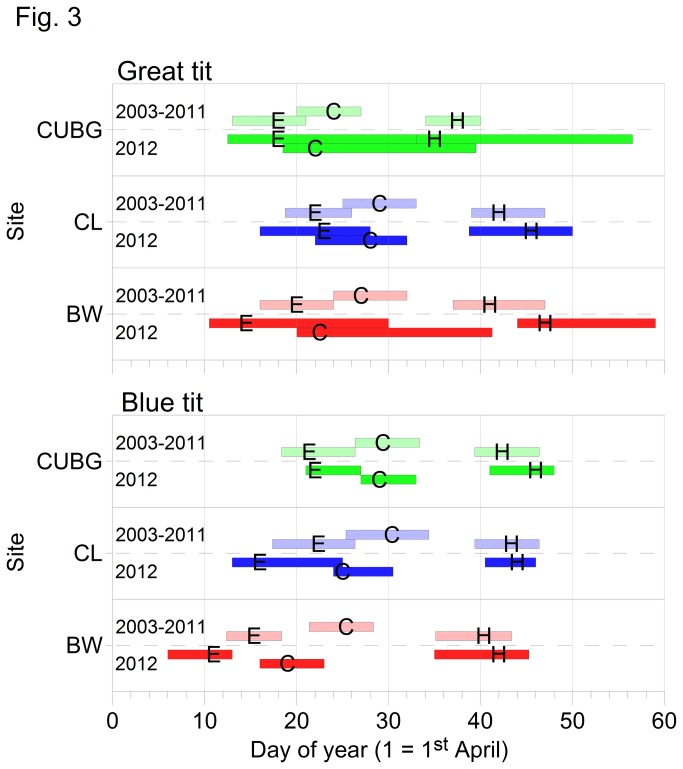
Average timing of nesting events for great tits (GT) and blue tits (BT) at Cambridge University Botanical Gardens (CUBG; green), Cow Lane Nature Reserve (CL; blue) and Brampton Wood Nature Reserve (BW; red).Symbols denote median dates for first egg (E), clutch completion (C; and earliest potential start of incubation) and hatching (H) and the bars show the interquartile range for the 9 year average 2003-2011 (hatched, upper), and 2012 only (solid, lower).